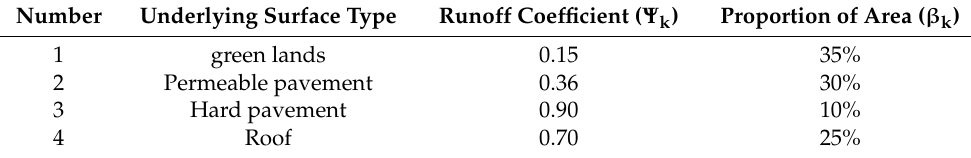
Table 5. The construction scheme of different underlying surfaces under the optimal